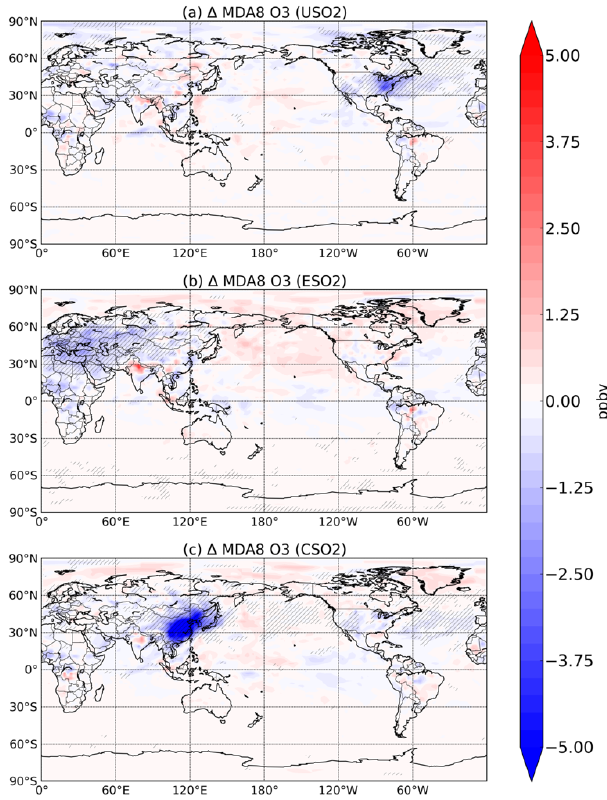
Figure 5. Summertime (JJA) surface O 3 change (in ppbv) between a control simulation and a perturbation simulation in which anthro- pogenic SO 2 emissions are removed over a certain region: (a) US, (b) Europe, and (c) China. Hatching denotes statistical significance according to a Student’s t test at the 95% confidence